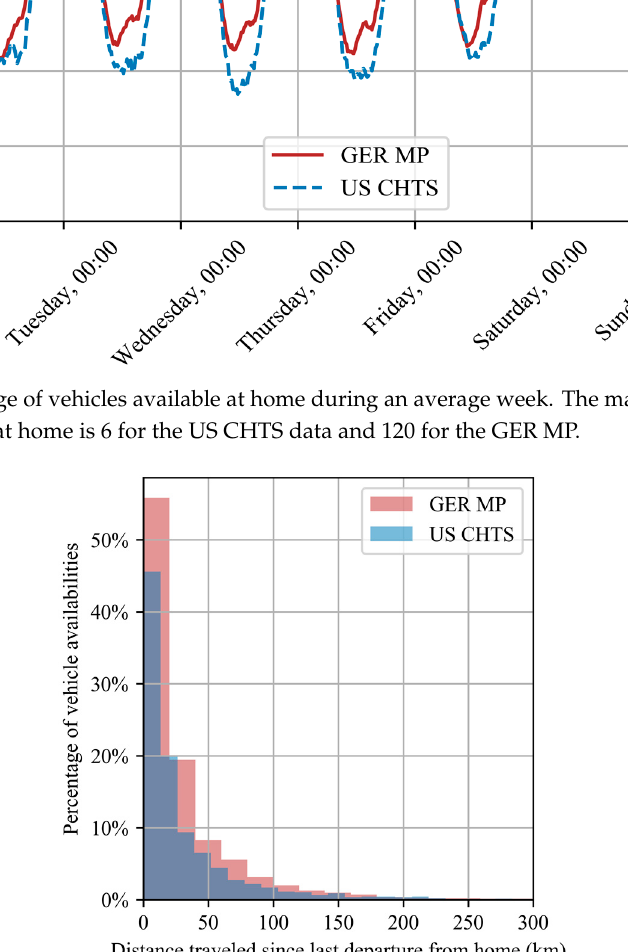
Figure 3. Percentage of vehicles available at home during an average week. The maximum number of vehicles available at home is 6 for the US CHTS data and 27 for the GER MP.